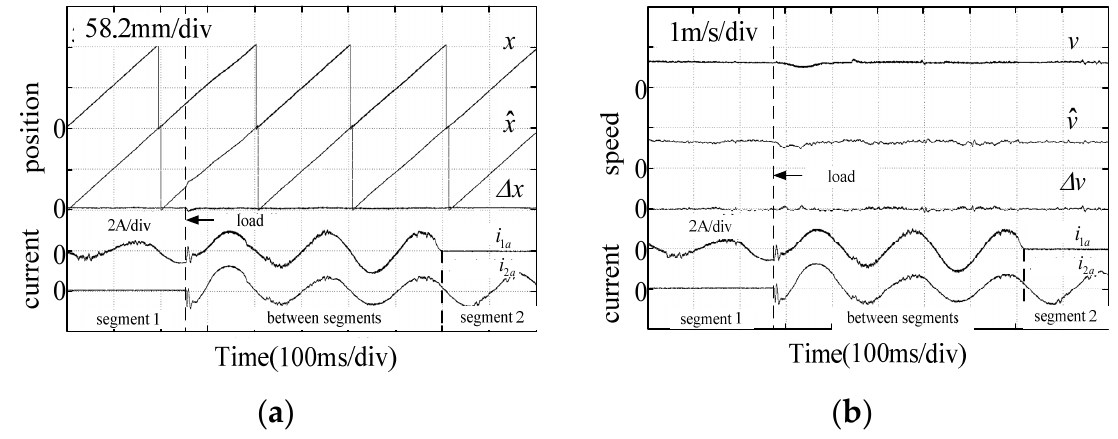
Figure 15. Load diagram of WS-PMLM.